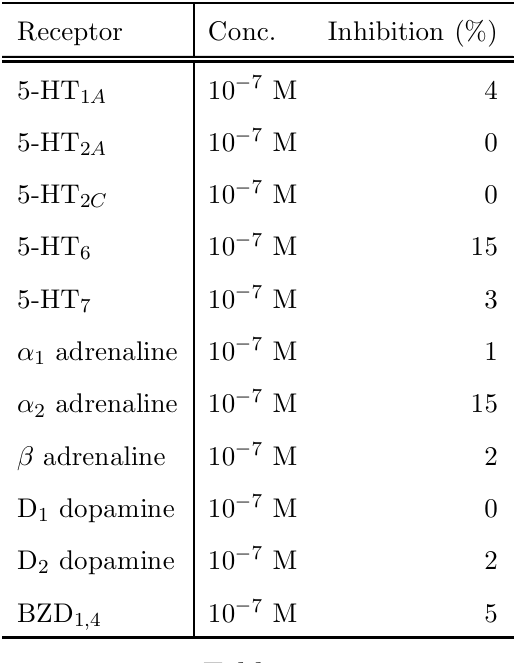
5 Formation of (11bSR,